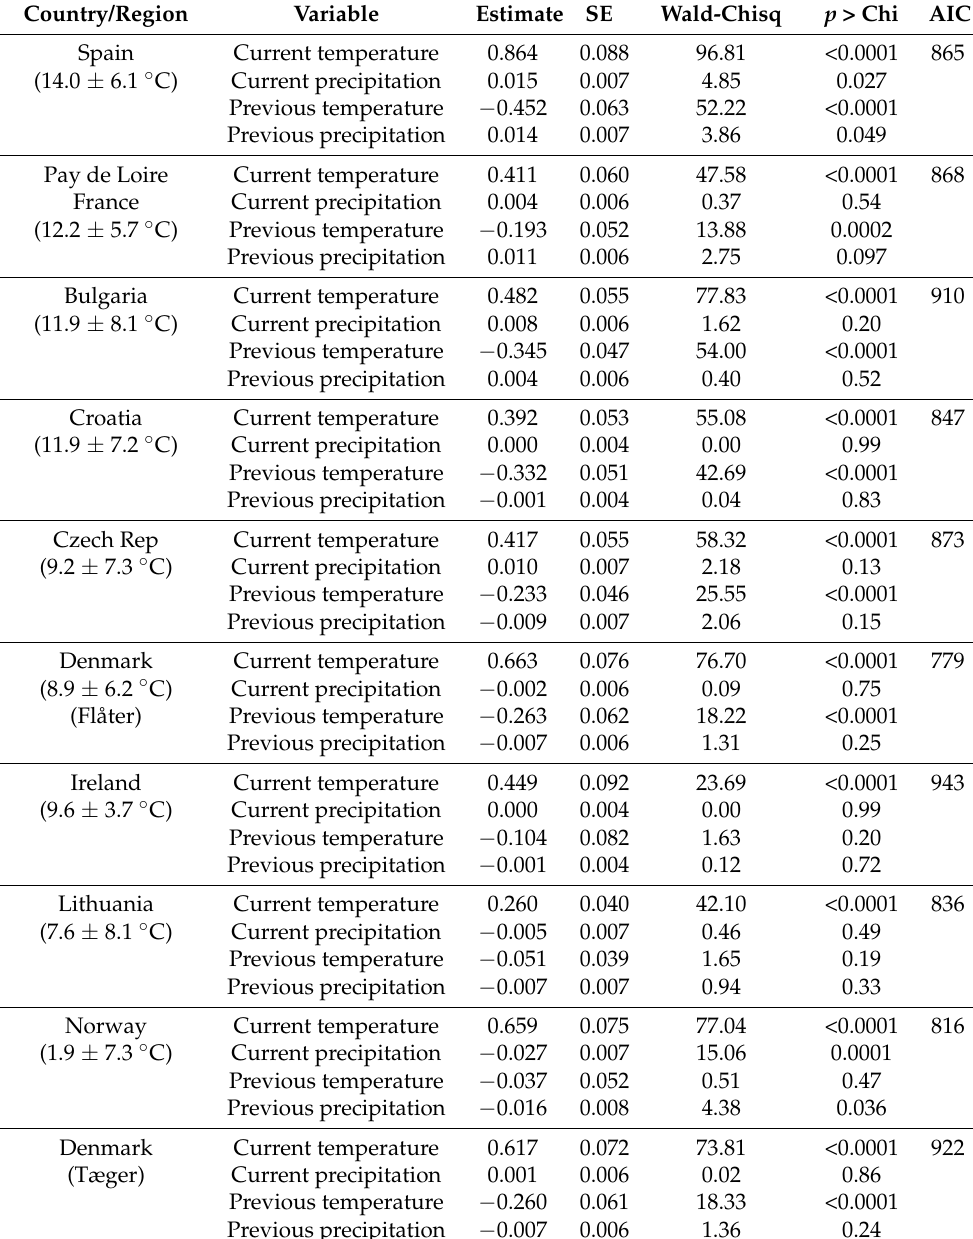
Table 3. Association between the frequency of online searches of tick in the national language and temperatures and precipitation in the current and previous month (2007–2016, n = 120). Country/Region